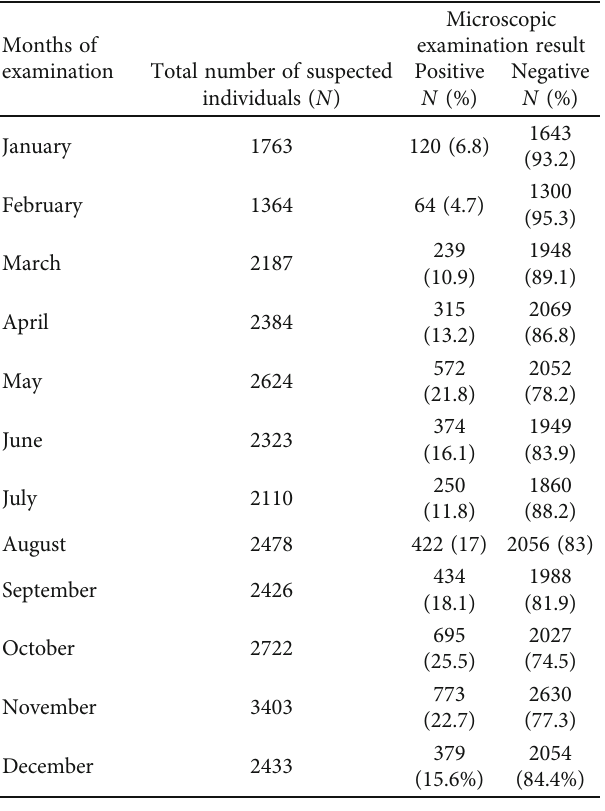
Figure 2: Seasonal distribution of malaria among individuals requested for malaria examination at Maksegnit Health Center from 2014 to 2020 ( n = 28217 ).